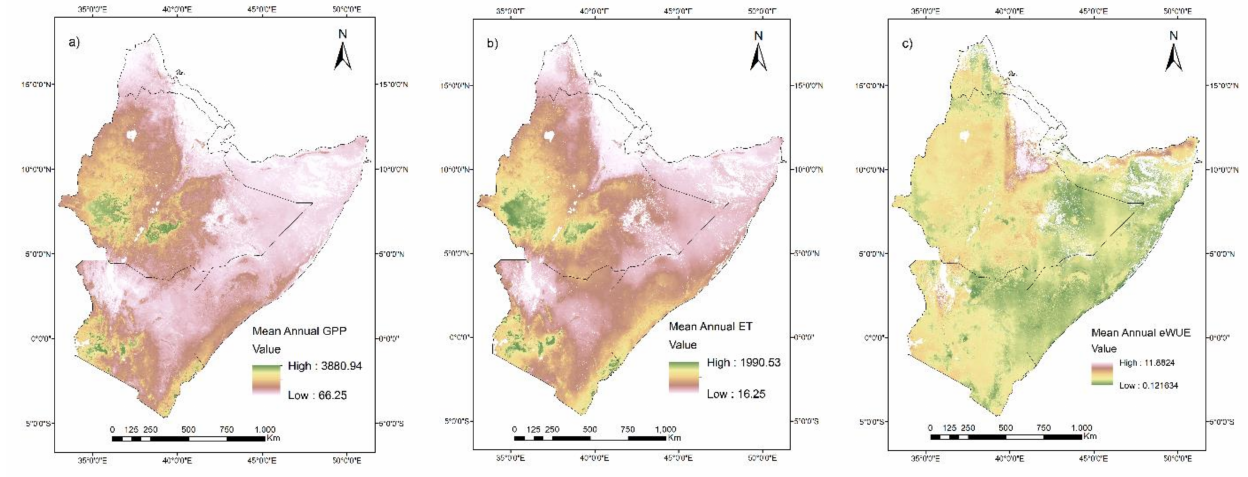
Figure 7. ( a ) Mean annual distributions of GPP ( a , in g C m − 2 ), of ET ( b , in mm) and of eWUE ( c , in g C kg − 1 H 2 O) during 2000–2014 in the Horn of